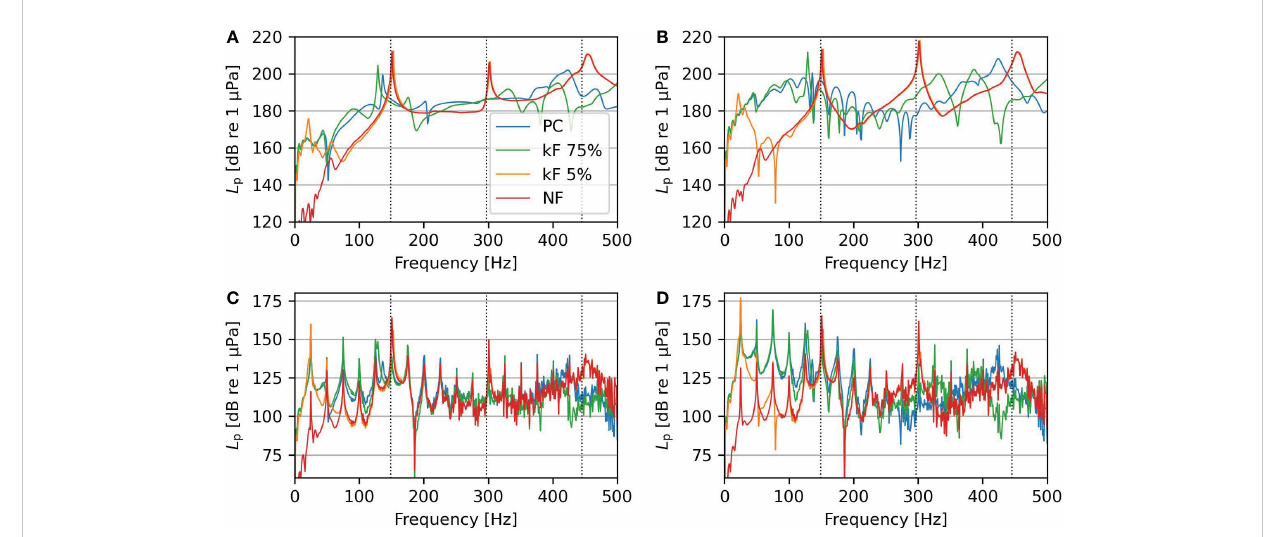
FIGURE 8 (A, B) show the sound pressure level transfer functions for a 1 MN harmonic load on top of the pile at a 20 m radius and z = 3 m and z = 7 m, respectively. (C, D) show the sound pressure levels resulting from the vibratory force from Figure 4 at a 20 m radius and z = 3 m and z = 7 m, respectively. The dotted vertical lines indicate the eigenfrequencies of the